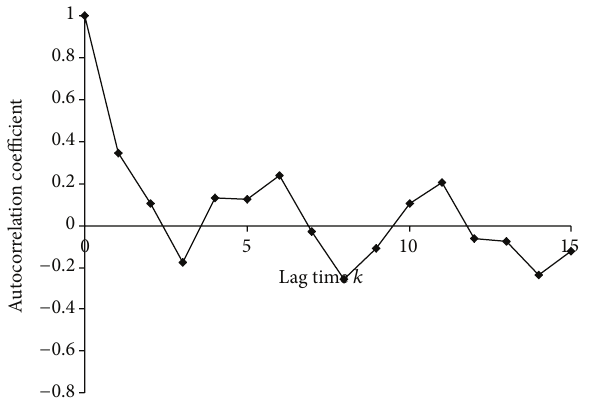
Figure 2: Autocorrelation coefficient and lag time of the annual runoff.